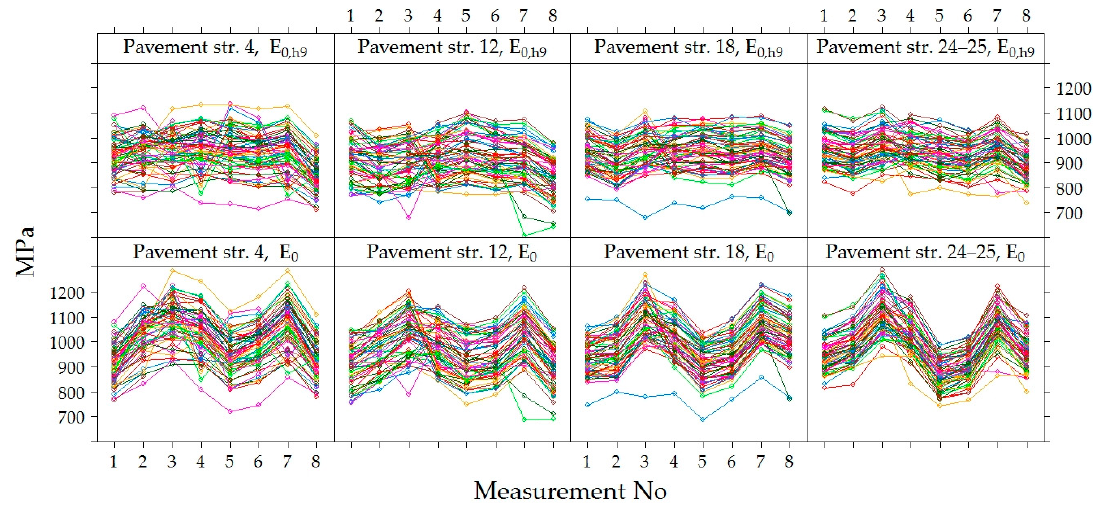
Figure 12. E 0 and E 0,h9 at individual measuring points [29].